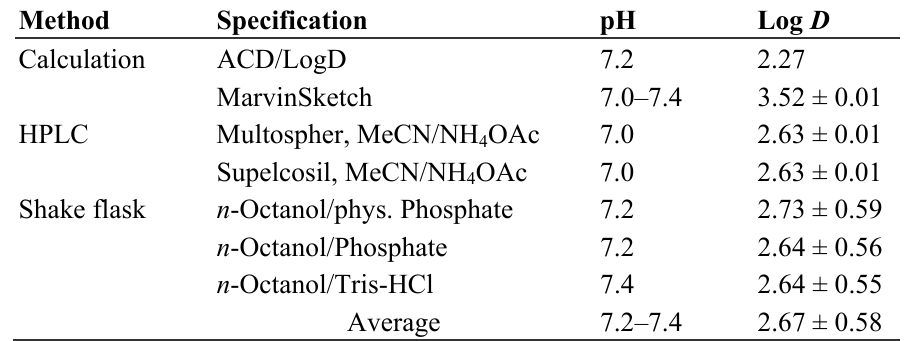
Table 1. Calculated and experimentally determined logarithmic distribution coefficients of [ 18/19 F] IV ; values given in single, or mean ± SD with n ≥